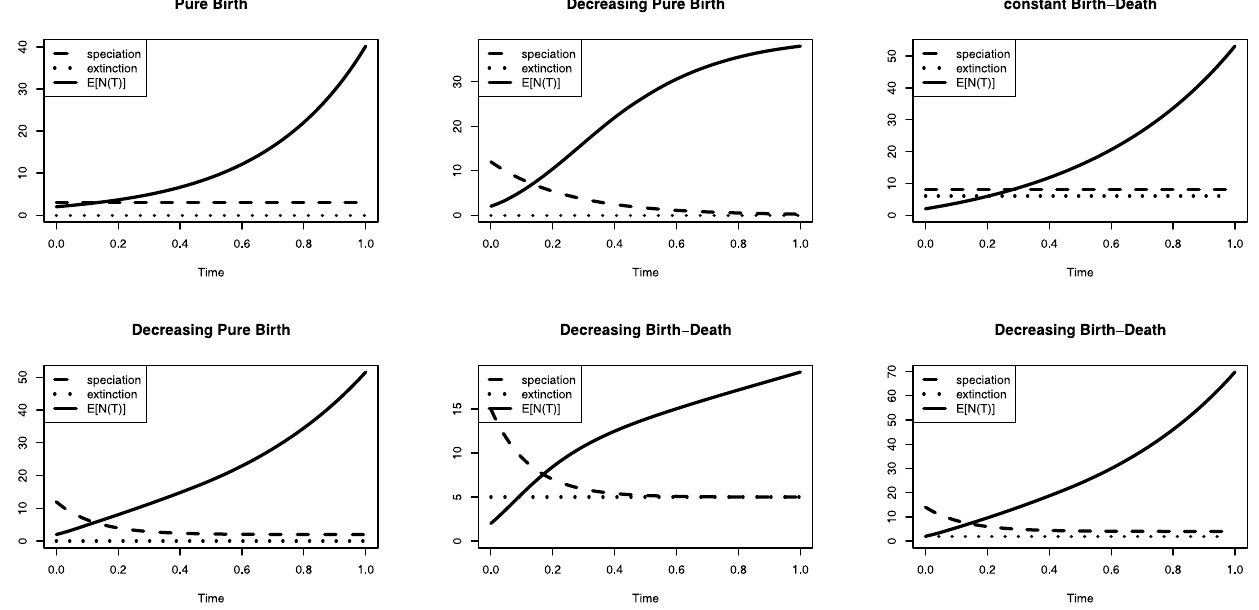
Figure 3. The six birth-death models used in this study. Each plot shows the speciation rate (dashed) and the extinction rate (dotted) over time, as well as the expected number of species ( E ½ N ( t ) (cid:3) ) if the process endured for a time t . Model 1: A constant-rate pure birth process. Model 2: A decreasing pure birth process with the speciation rate declining towards zero as time continues. Model 3: A constant-rate birth-death process. Model 4: A pure birth process with a constant part of the speciation rate and a decreasing part of the speciation rate. Model 5: A birth-death process with an initial phase of expansion (higher speciation rate than extinction rate) and afterwards converging to a critical branching process. Model 6: A birth- death process with a constant extinction rate, a constant part of the speciation rate and a decreasing part of the speciation